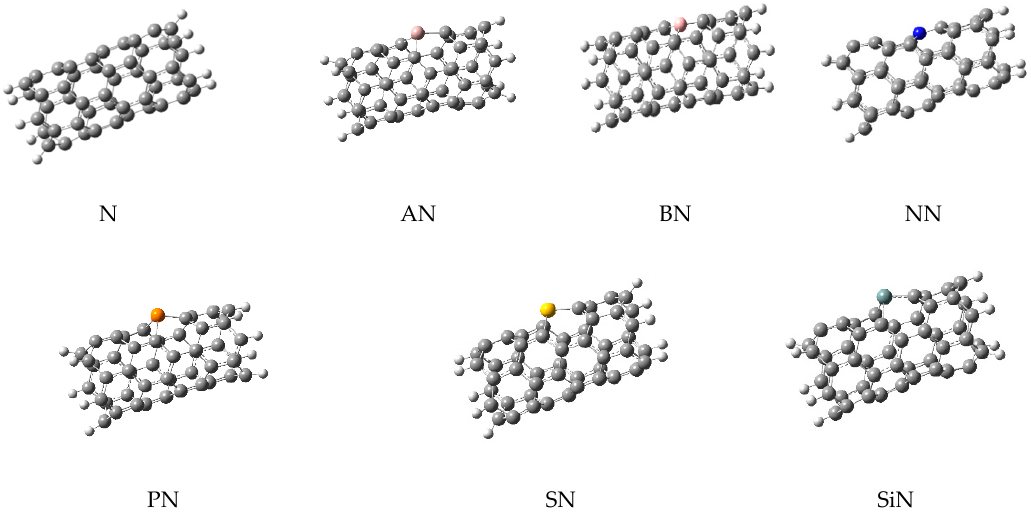
Figure 1. The optimized structures of simple and doped nanotubes employed in this work. Table 1. The most important molecular parameters of simple and doped nanotubes, alone and in complex, with H 2 S, SO 2 , and thiophene. All distances were reported in Å. N